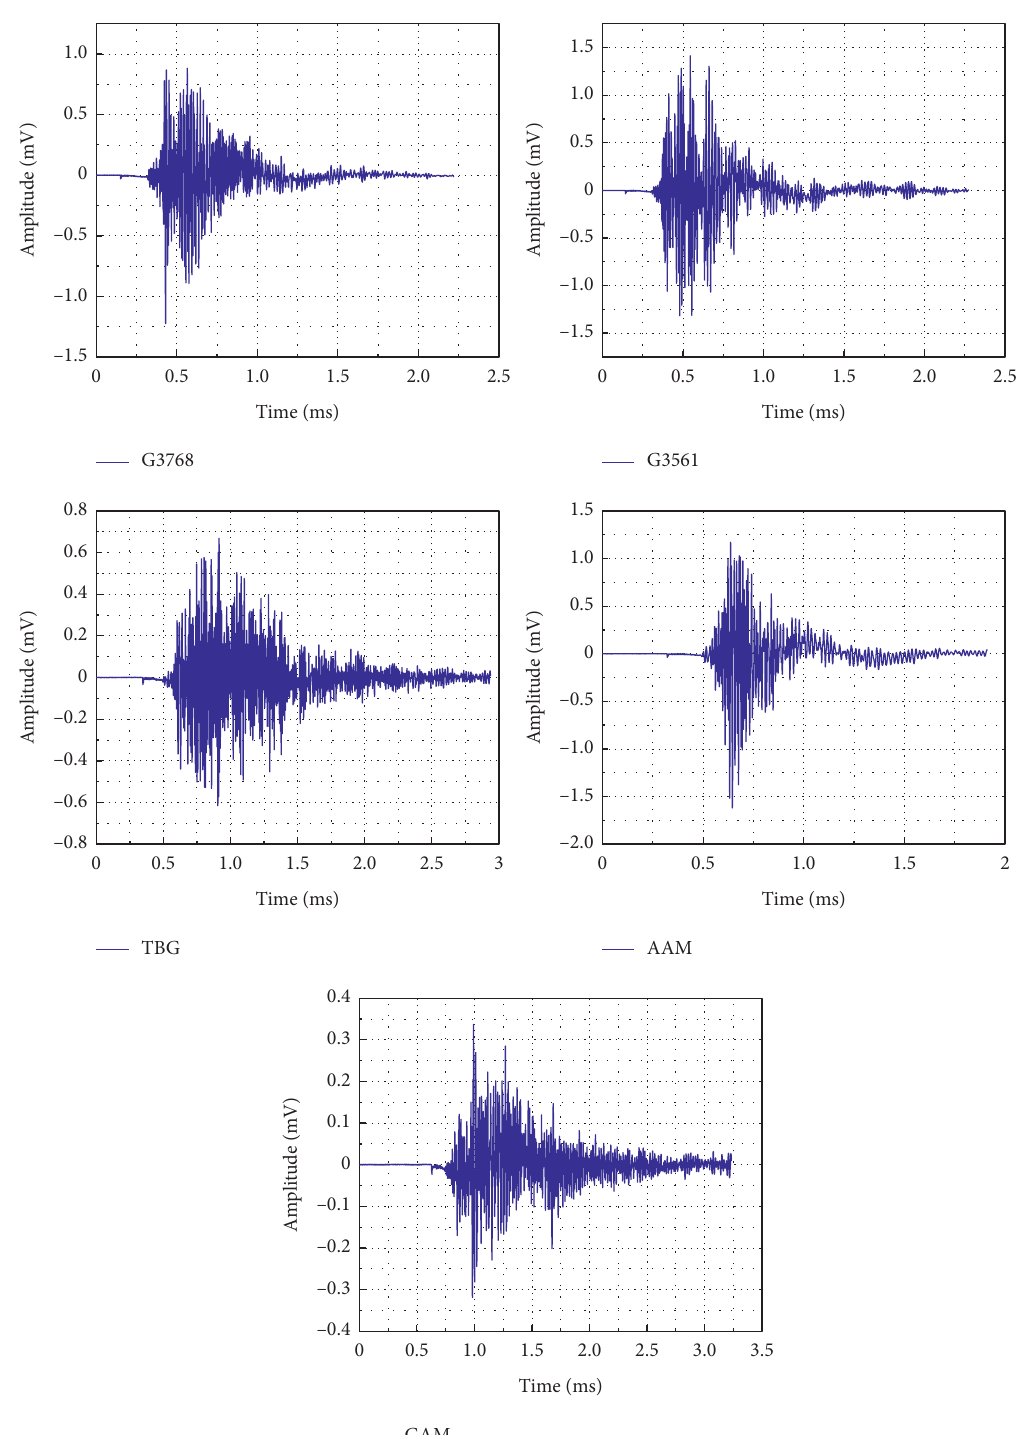
Figure 7: Time domain waveform of measuring point M2 of rod-shaped